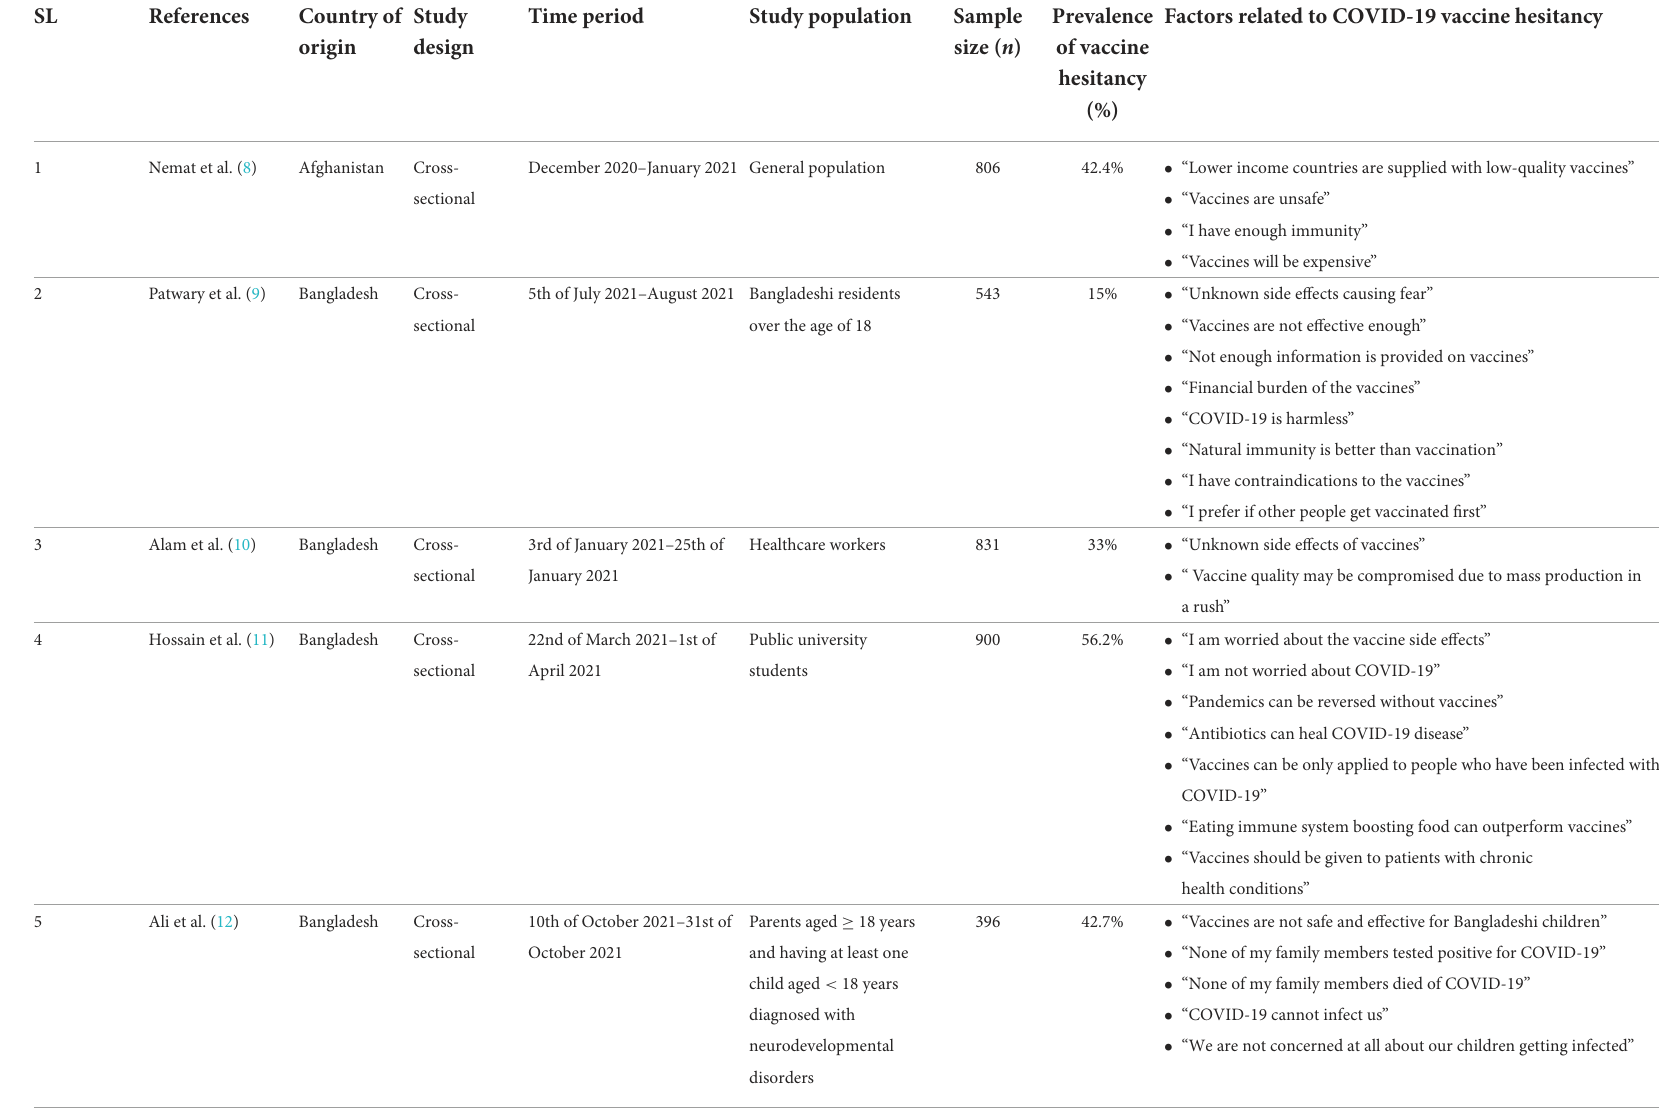
TABLE 1 Survey-based cross-sectional studies included in this narrative review relevant to COVID-19 vaccine hesitancy factors in Afghanistan, Pakistan, India, and